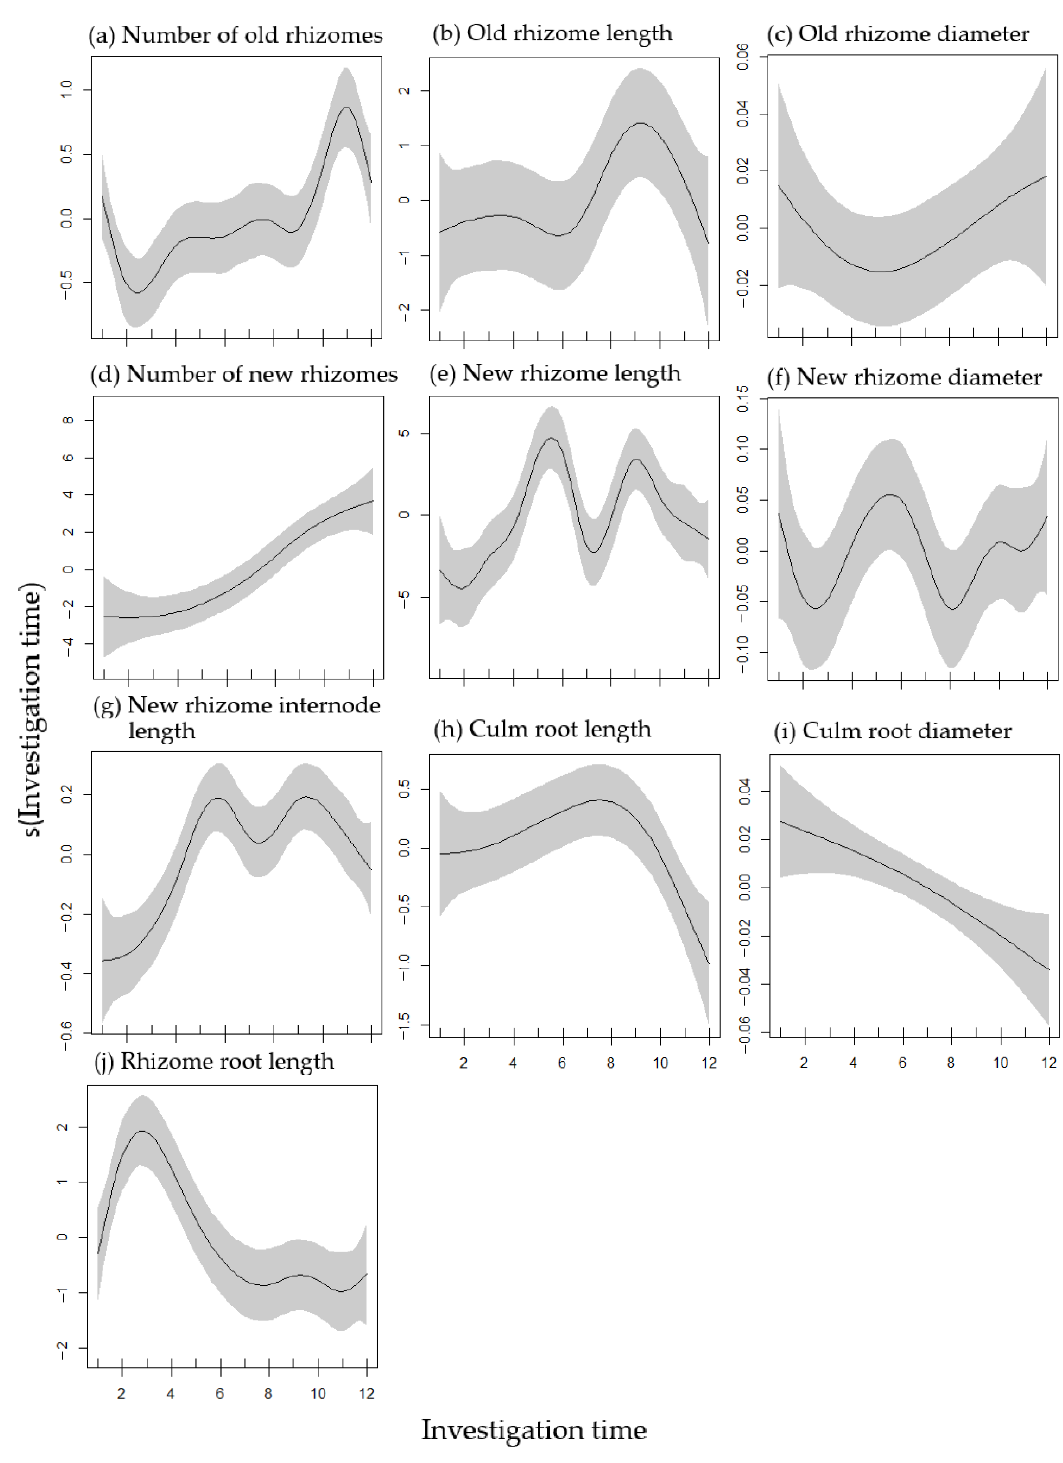
Figure 2. The plots of the GAMs smooth function for indicating the effects of investigation time on the number of old rhizomes ( a ), old rhizome length ( b ), old rhizome diameter ( c ), number of new rhizomes ( d ), new rhizome length ( e ), new rhizome diameter ( f ), new rhizome internode length ( g ), culm root length ( h ), culm root diameter ( i ) and rhizome root length ( j ). The grey ribbon shadow indicates the 95% confidence intervals of the fitted smoothers. The investigation times 1–12 in 2016 are 1 = 15 April, 2 = 9 May, 3 = 3 June, 4 = 27 June, 5 = 21 July, 6 = 12 August, 7 = 5 September, 8 = 23 September, 9 = 17 October, 10 = 10 November, 11 = 2 December, 12 = 26 December. As the investigated time increased from one to twelve, the culm root diameter signif- icantly reduced (degrees of freedom = 1.331, p < 0.01, Table 1, Figure 2i). However, the